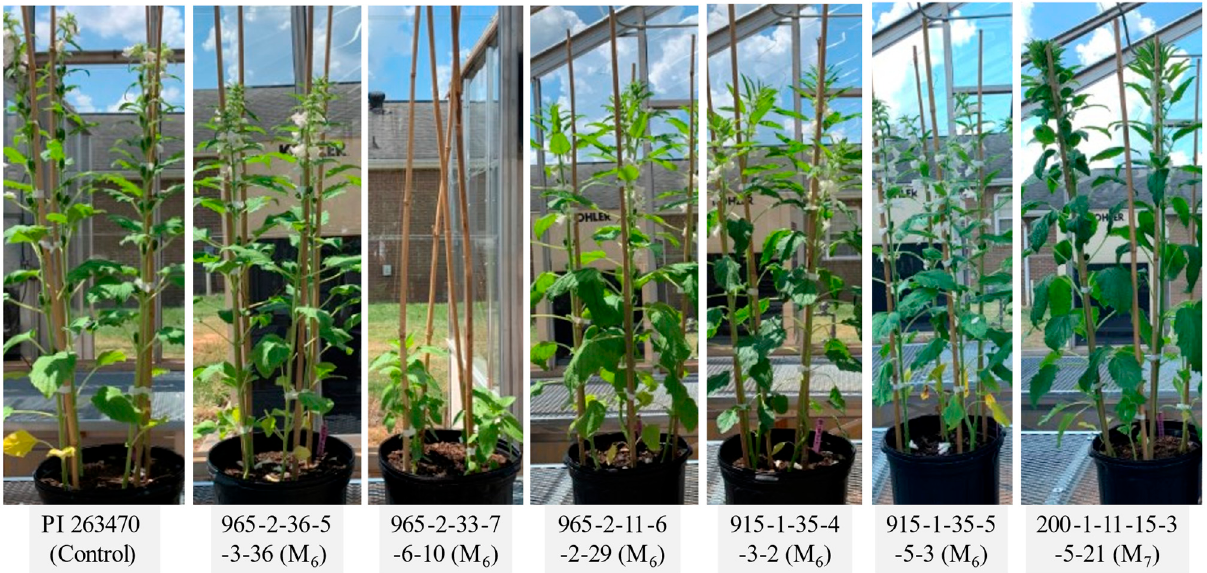
Figure 5. Comparison of plant morphology between mutant line and control at a high generations.